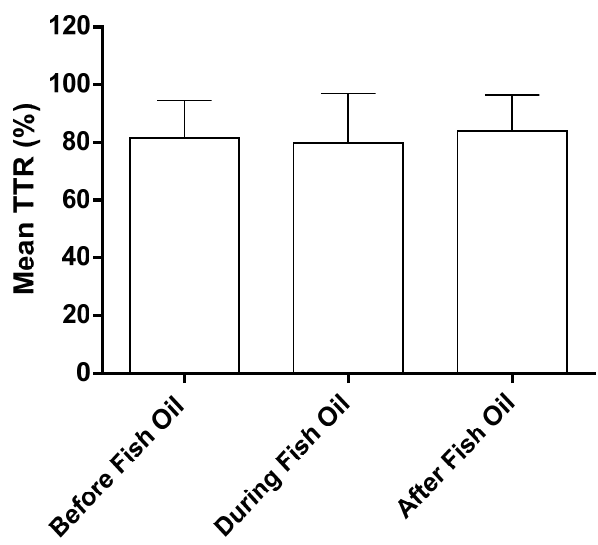
Figure 2. Mean TTR for patients before, during, and after fish oil supplementation. Data is shown as the mean and standard deviation, n = 24.